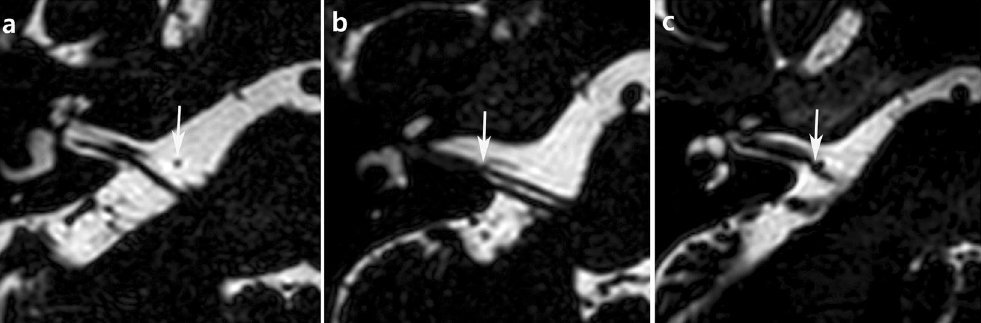
Figure 2. The types of neurovascular contact. ( a ) There is no neurovascular contact (arrow), which is classified as type I. ( b ) Type II shows neurovascular contact (arrow) between AICA and cochleovestibular nerve without angulation/indentation of the nerve. ( c ) Arrow indicates the angulation/indentation of cochleovestibular nerve by AICA loop in type